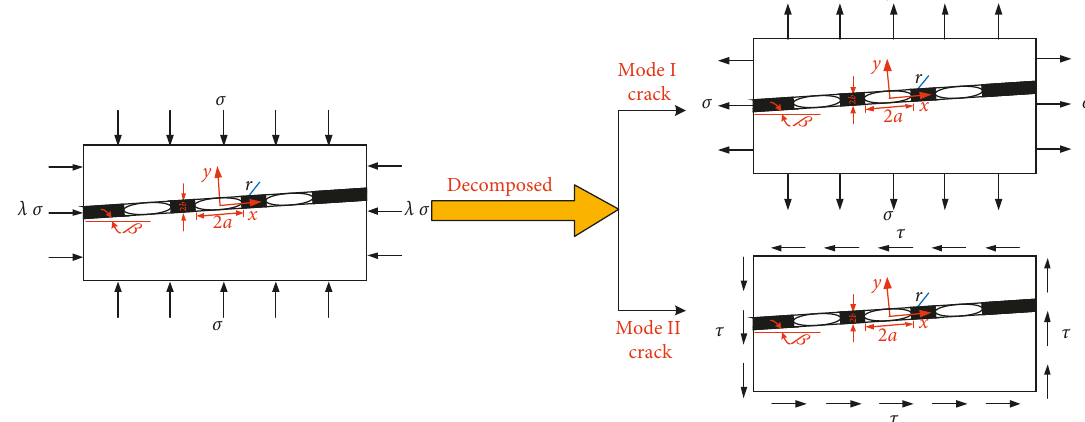
Figure 4: The analysis of damaged width at the rib